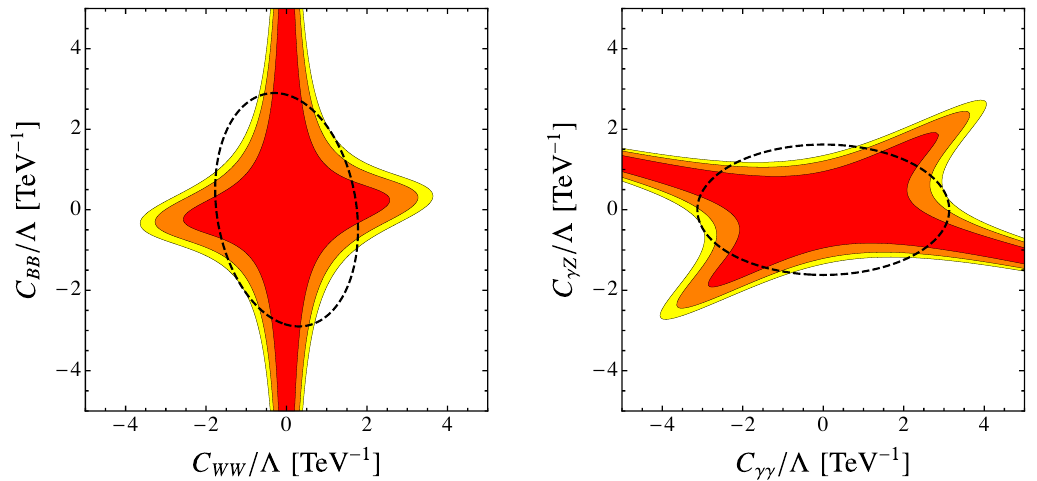
Figure 28 . Allowed regions in the parameters space of the Wilson coe(cid:14)cients C and C (cid:13)(cid:13) C (cid:13)Z (right) obtained from projections for the two-parameter global electroweak (cid:12)t at (cid:0) a future FCC-ee machine [121] at 68% CL (red), 95% CL (orange) and 99% CL (yellow),